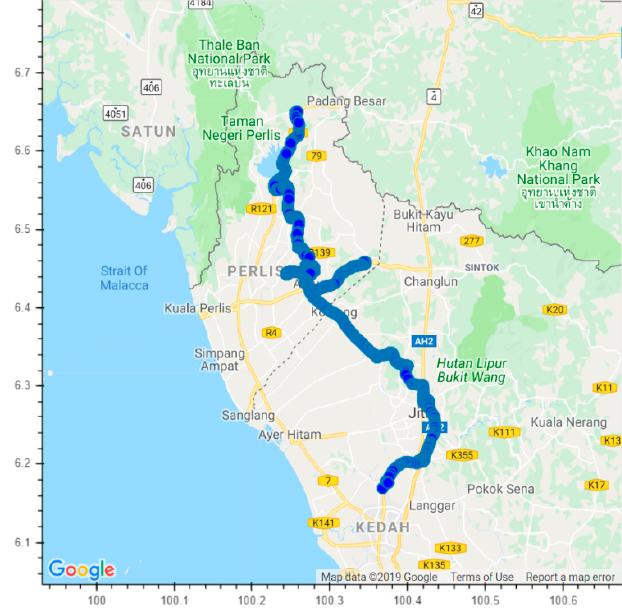
Figure 4. The daily travelled path in the experiment. Table 2. Data features and samples size for the in-vehicle air quality.